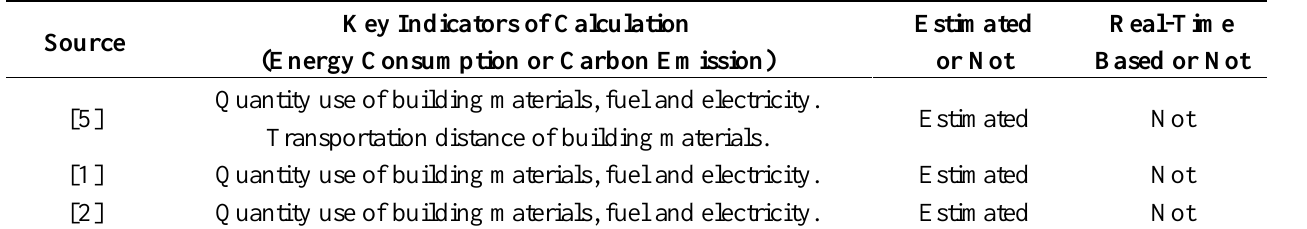
Table 1. Estimation of key indications of calculation in recent